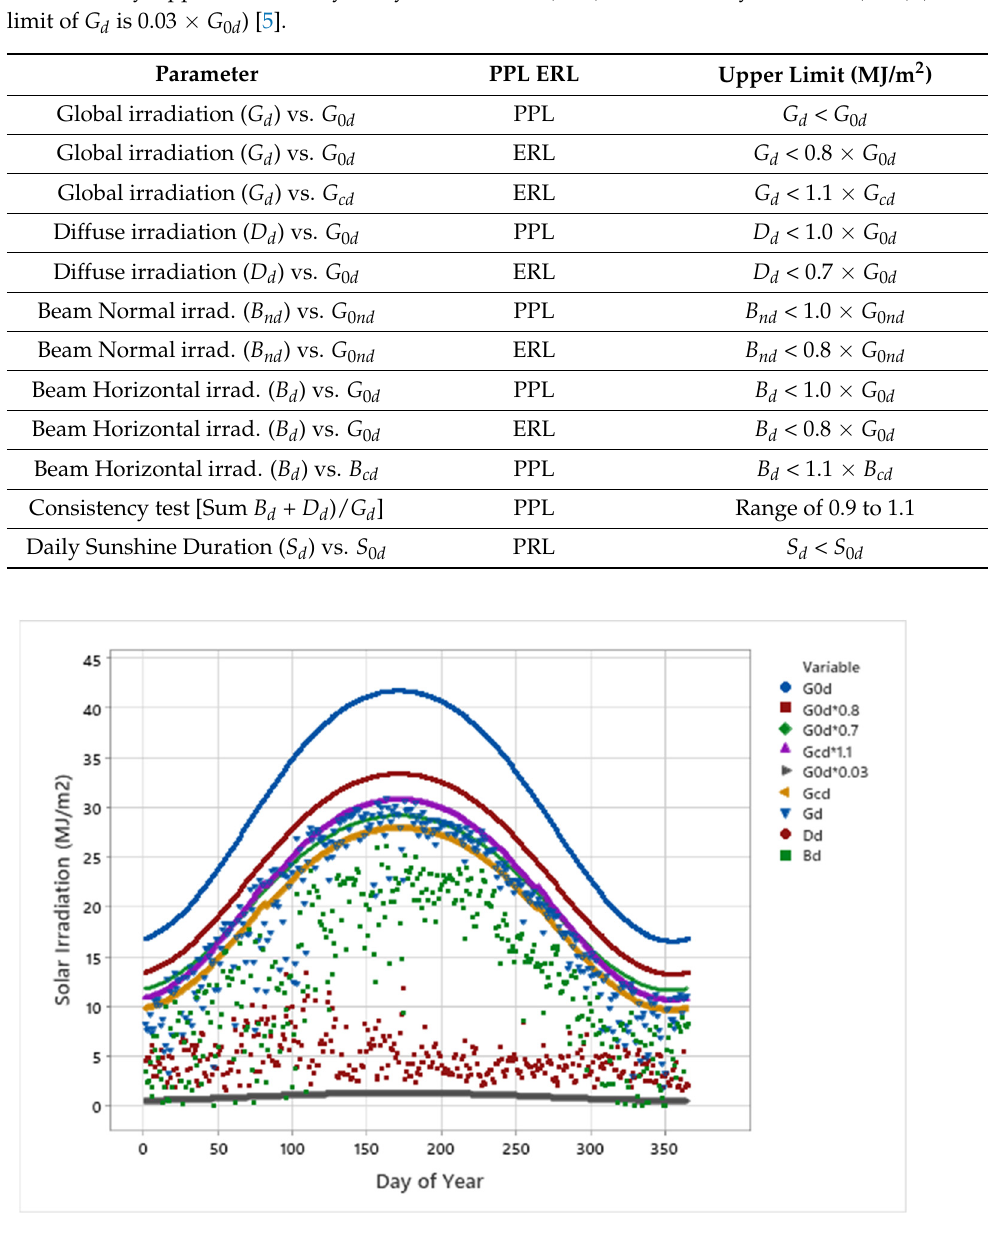
Figure 11. Daily totals of global irradiation ( G d ) compared to the respective extraterrestrial ( G 0 d ) and clear-sky irradiation ( G cd ). The daily totals of horizontal direct ( B d ) and diffuse irradiation ( D d ) are also shown in the graph.